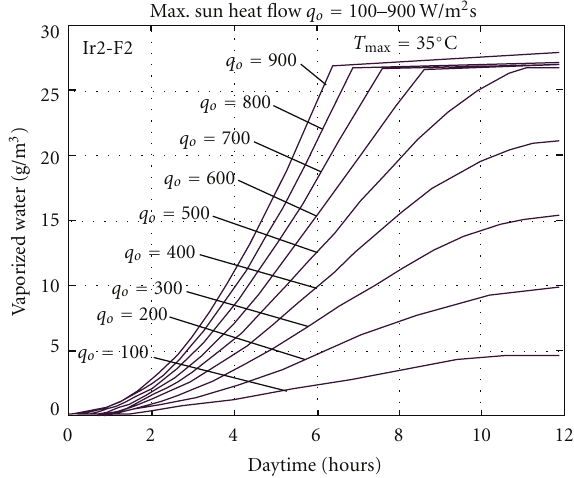
Figure 16: Water vaporization for 100% humidity of the air for di ff erent maximal solar radiation (W/m 2 ) levels delivered over varying daily time. Height of dome film cover equals H = 135m. The temperature control system limits the maximum internal dome temperature to 35 ◦ C.